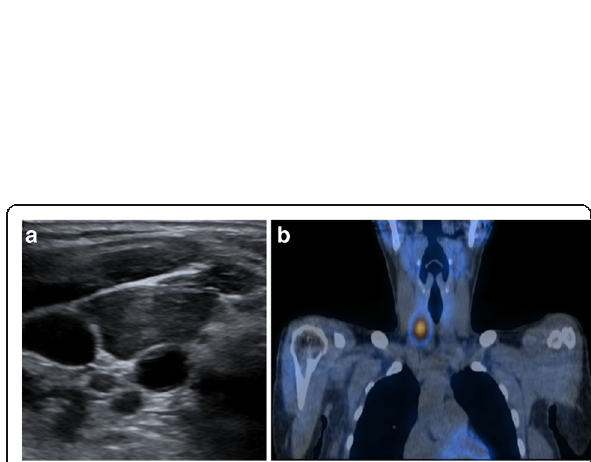
Fig. 10 Chest radiograph of the same patient showed sclerotic expansion of the left lateral